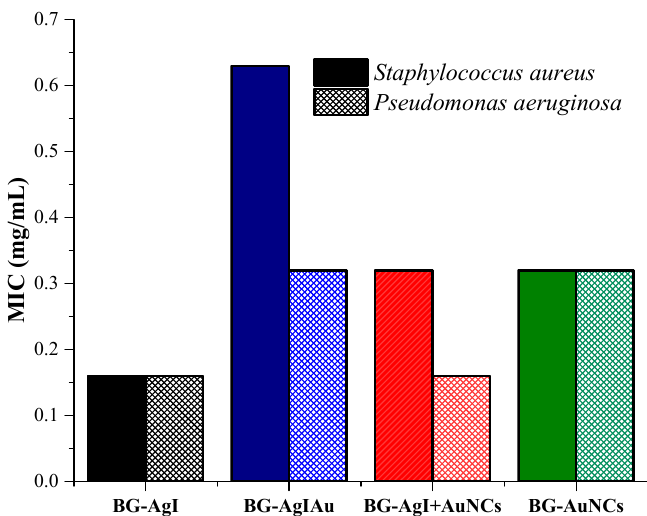
BG-AgI BG-AgIAu